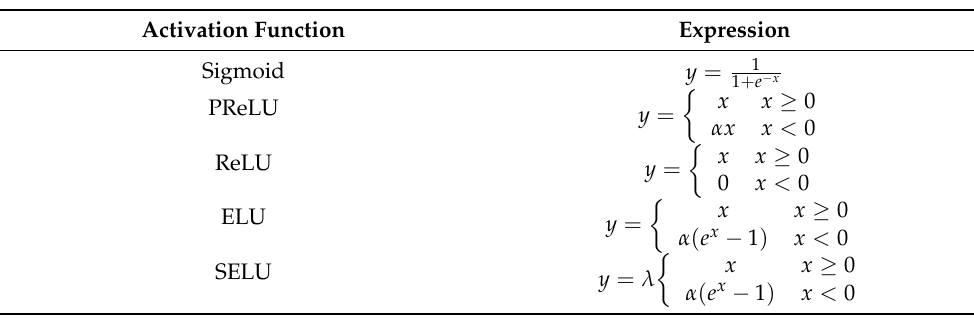
Table 1. Typical activation